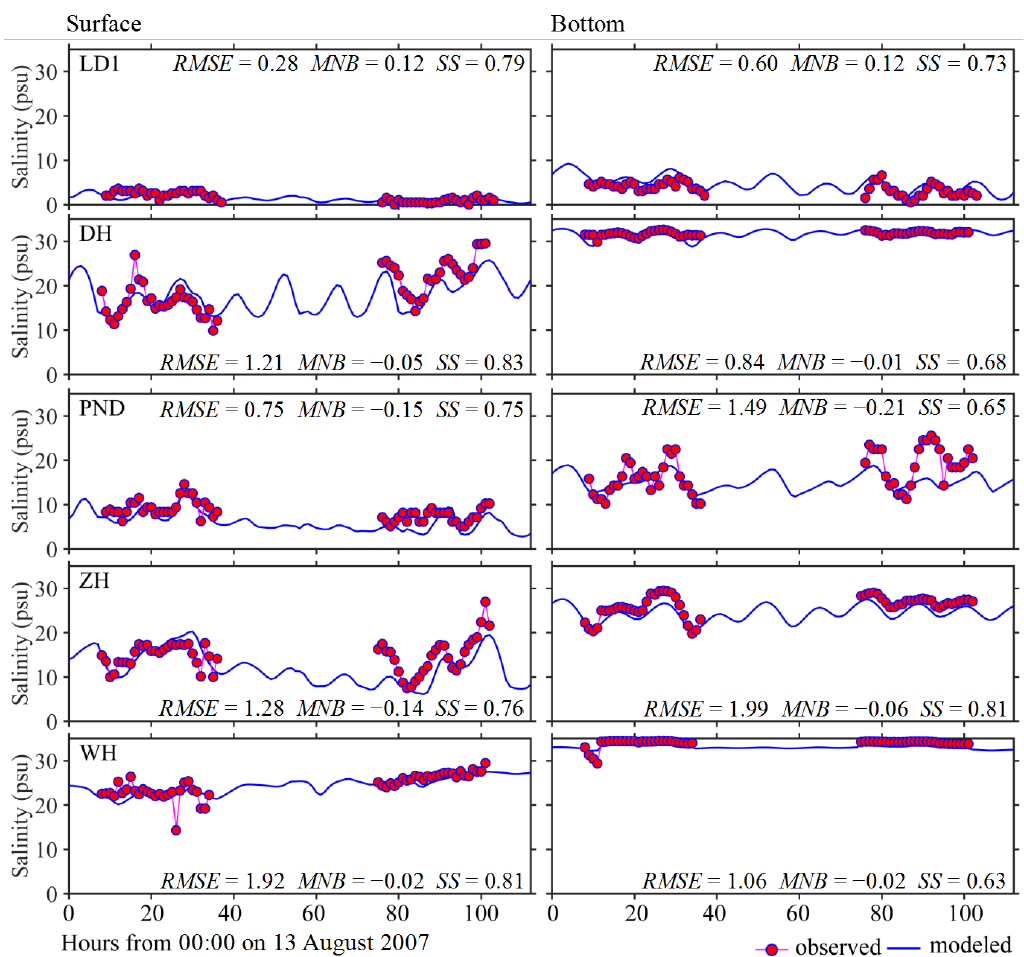
Figure 7. Comparisons of surface and bottom salinity. The locations of the stations LD1, DH, PND, ZH and WH are shown in Figure 2 by black dots.